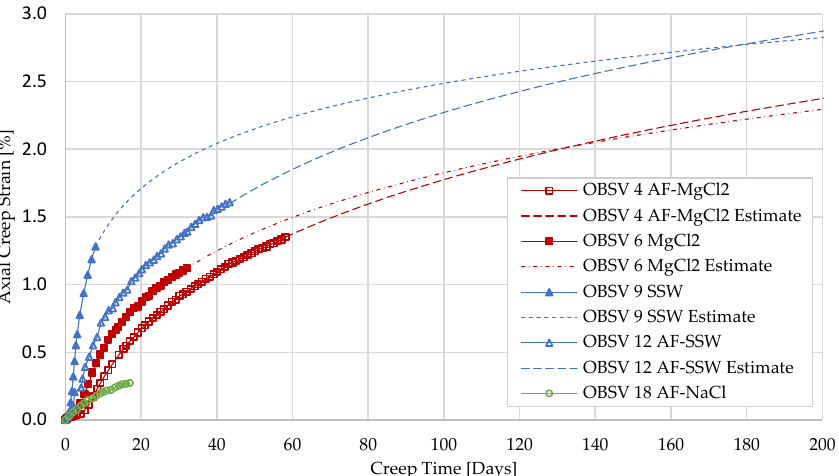
Figure 9. Extrapolation of the geo-mechanical response of creep rates for two artificially fractured samples (OBSV 4 AF-MgCl 2 and OBSV 12 AF-SSW) and two unfractured samples (OBSV 6 MgCl 2 and OBSV 9 SSW) over a period of 200 days.